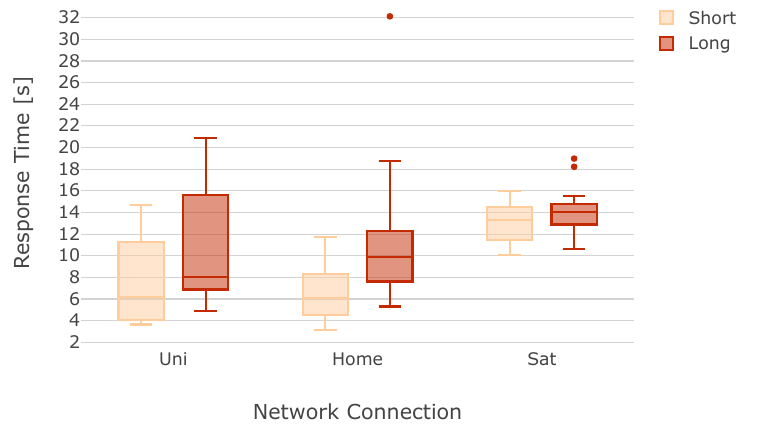
Figure 19. Response time using the UNI, HOME and SAT network connections, in case of a pre- loaded video on Google Cloud Service server, with different video lengths (short and